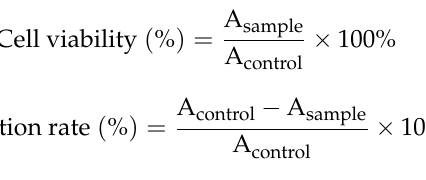
Figure S2: UV spectra of six ginkgols, Figure S3: 1 HNMR, and 13 CNMR spectra of six ginkgols, Figure S4: The chromatograms of the various ginkgols G-1, G-2, G-3, G-4, G-5, and G-6. Table S1: Molarity of six ginkgols for anticancer activity